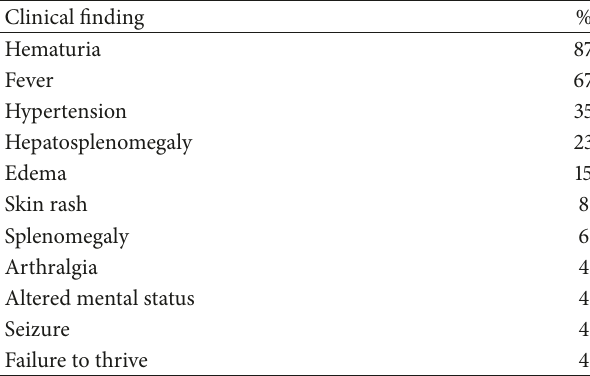
Table 3: Presenting signs and symptoms of shunt